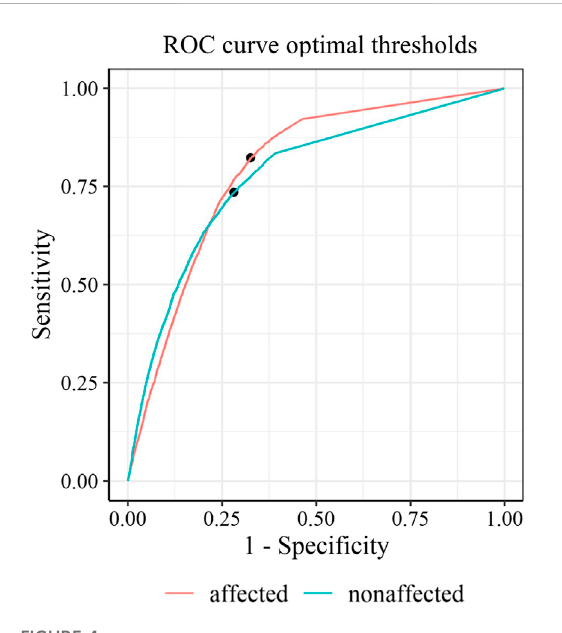
FIGURE 4 Receiver operating characteristic curves with optimal thresholds for the affected side (red) and the non-affected side